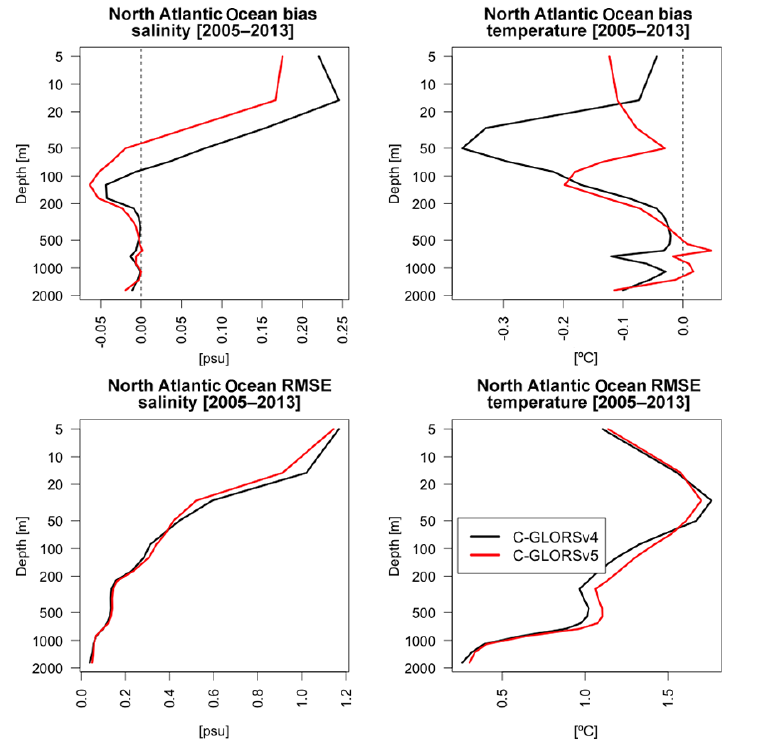
Figure 7. As Fig. 5, but for the North Atlantic Ocean skill scores (between 20 ◦ S and 60 ◦ N and between 80 and 10 ◦ W).